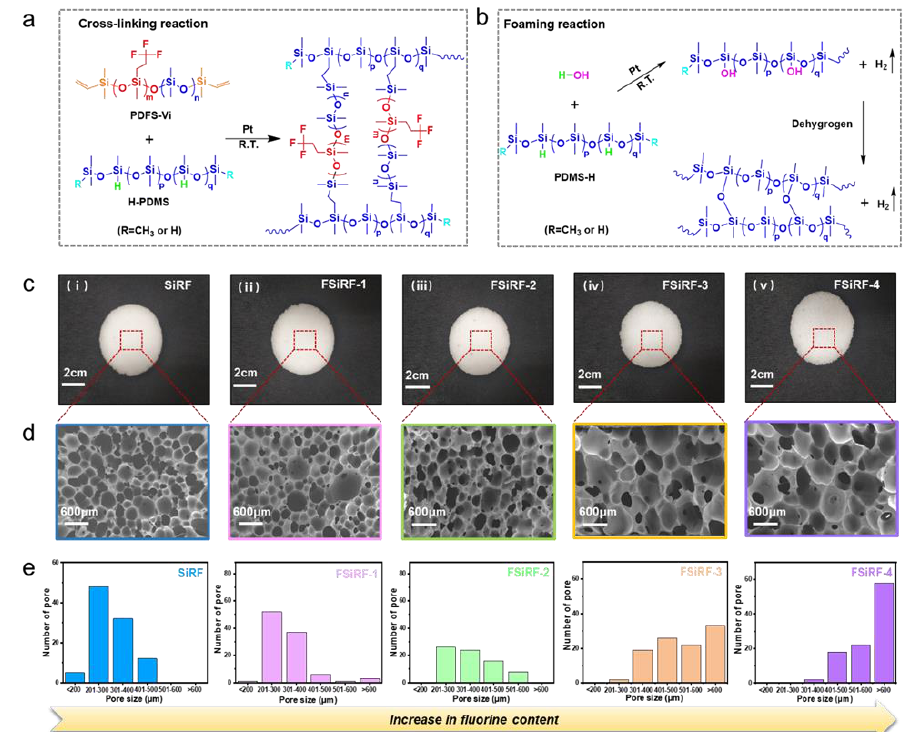
Figure 3. ( a ) Crosslinking and ( b ) foaming process of FSiRF materials at ambient temperature. Structural characterization and analysis of various FSiRF samples. ( c ) Photographs of ( ⅰ ) pure SiRF, ( ⅱ ) FSiRF-1, ( ⅲ ) FSiRF-2, ( ⅳ ) FSiRF-3, and ( ⅴ ) FSiRF-4. ( d ) SEM micrographs and ( e ) pore size distribution of FSiRF materials with different fluorine contents, indicating the pore size increases with the increase in fluorine content.